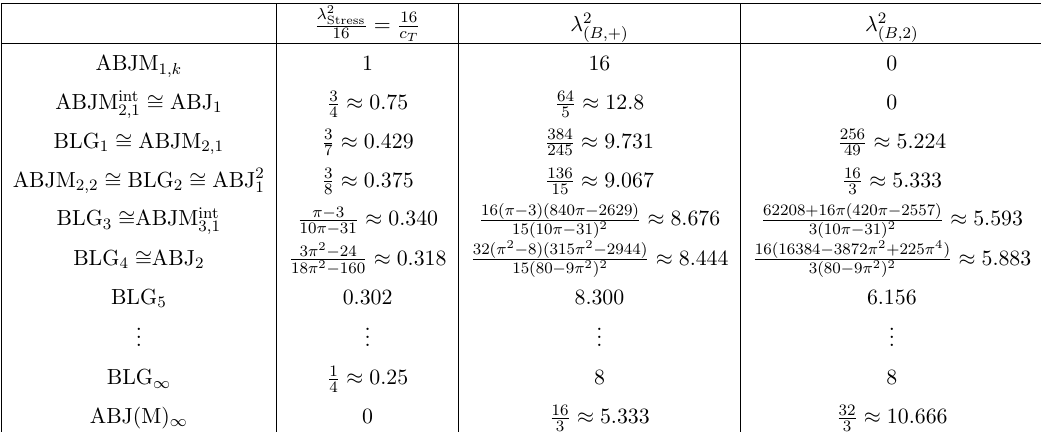
Table 4 . OPE coe(cid:14)cients of 1 theories. \ (cid:24) =" denotes that theories have the same stress tensor four-point function.